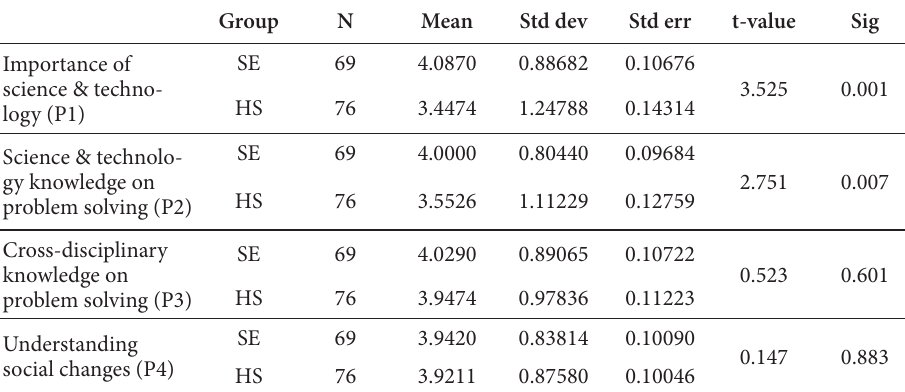
Table 5. Group means for the area knowledge